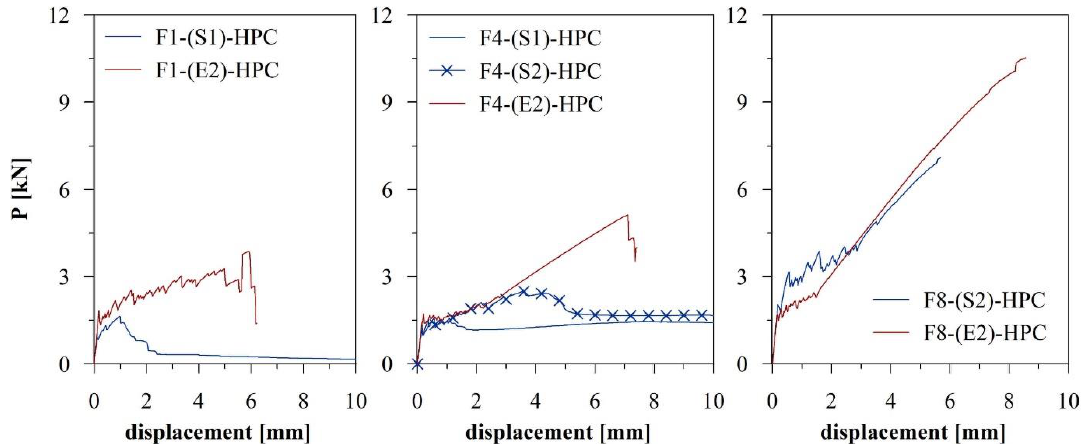
Figure 12. Average tensile response in terms of load vs. displacement curves for the F1/F4/F8-based TRC composites in the warp direction.